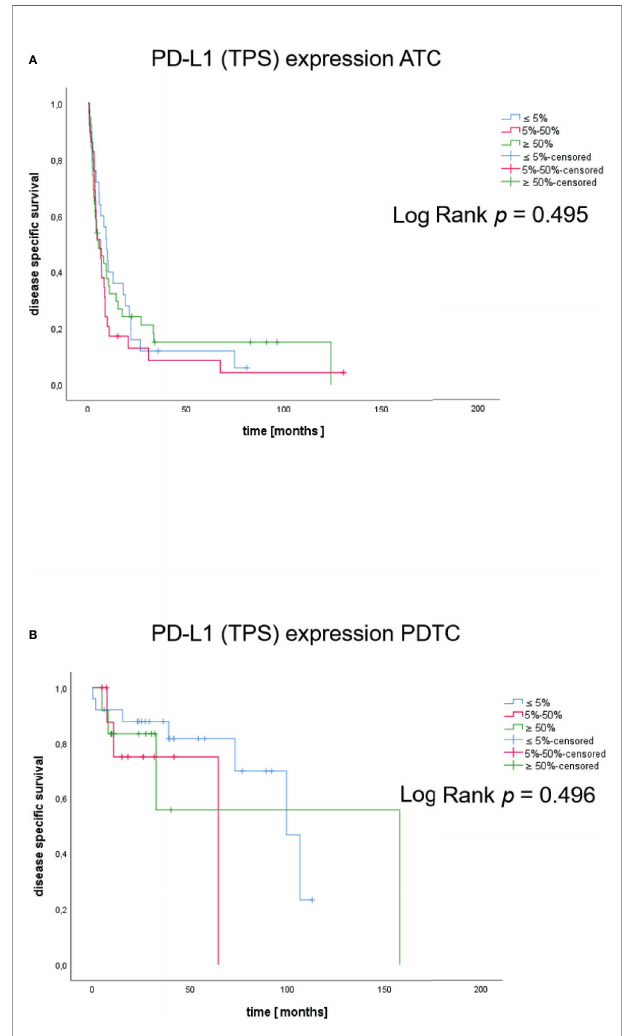
FIGURE 6 | Kaplan-Meier plots of DSS in patients according to PD-L1 expression. Disease speci fi c survival of ATC (A) and PDTC (B) patients with TPS categories ≤ 5%, 5-50%, ≥